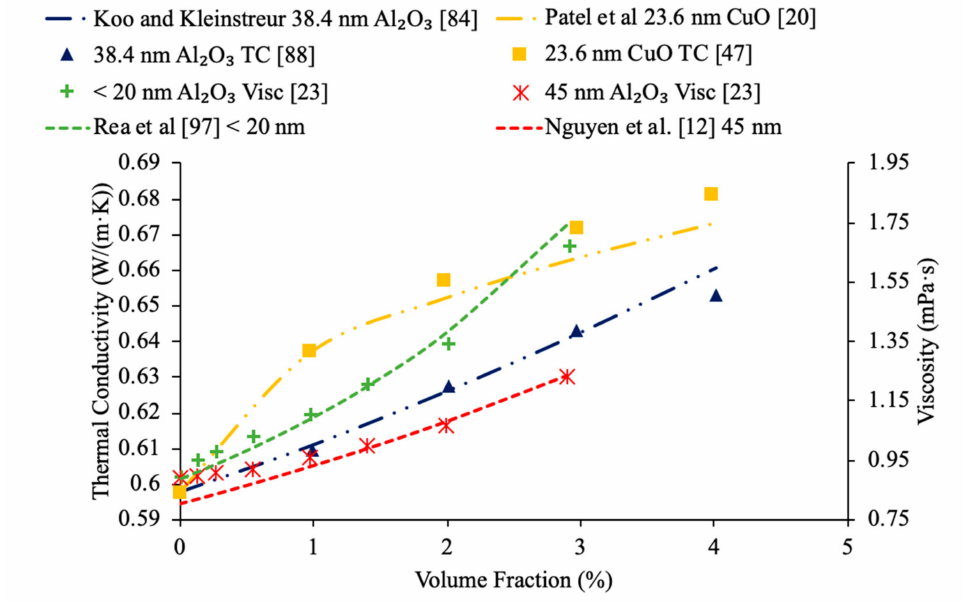
Figure 39. Combined figure showing nanofluid thermal conductivity (TC) and viscosity (Visc) dependence on volume fraction for various sizes of CuO–water and Al 2 O 3 –water nanofluids in comparison to different theoretical models [12,25,84,97].